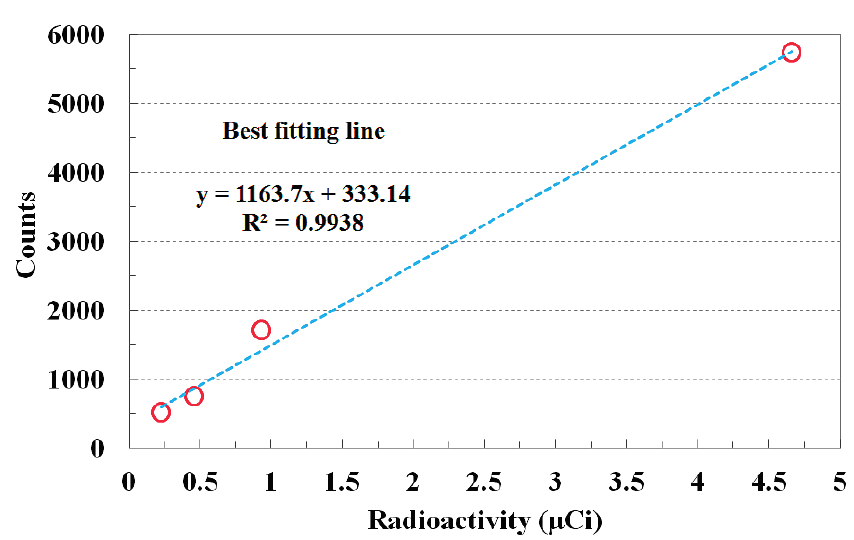
Figure 7. Response of the FORS according to the radioactivity variation of